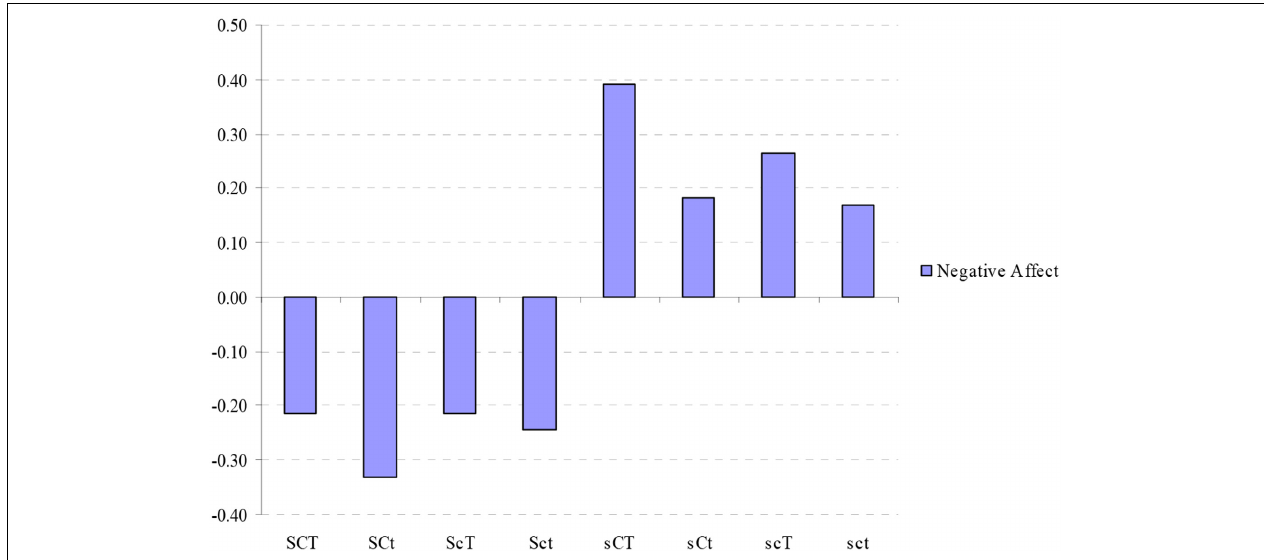
FIGURE 2 | Standardized values (mean = 0, SD = 1) of negative affect in different character combinations. SCT, creative; SCt, Organized; ScT, Fanatical; Sct, Autocratic; sCT, Moody; sCt, Dependent; scT, Disorganized; sct, Depressive; ANOVA: F = 9.84, p = 0 . 00.